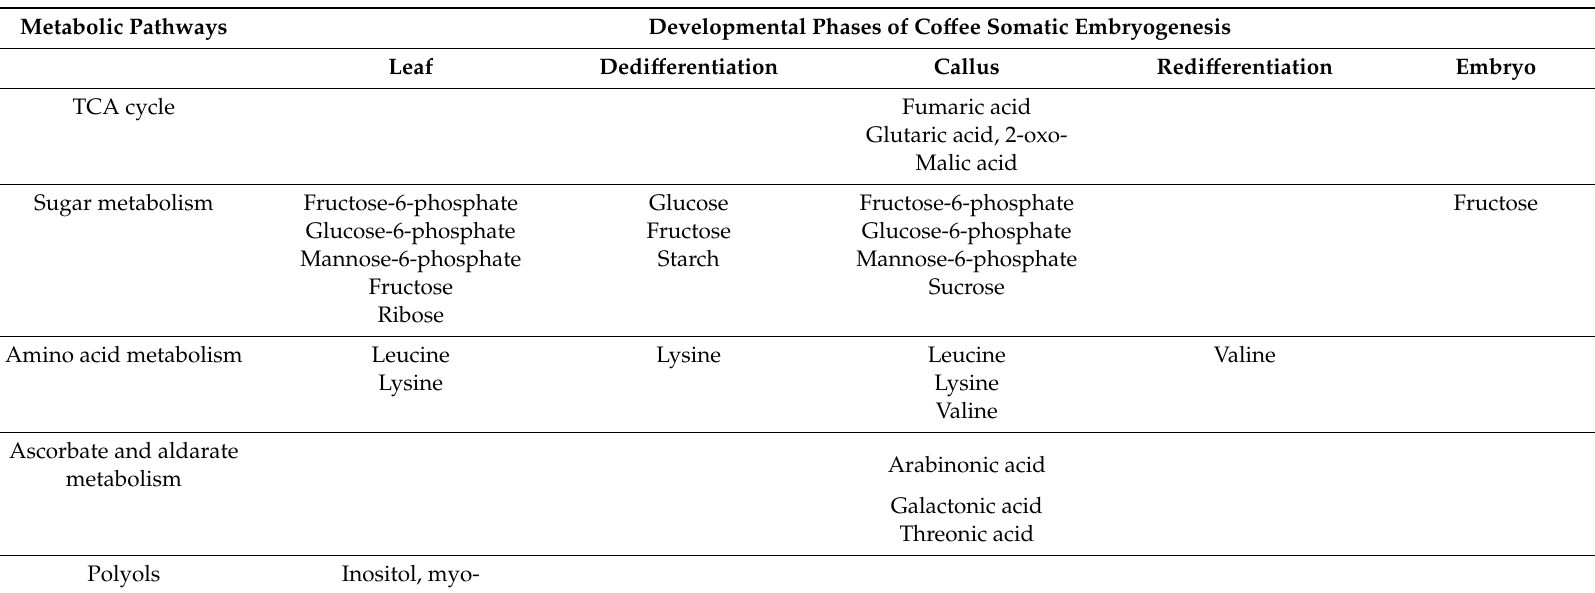
Table 3. Significantly under-accumulated metabolites in the five developmental phases forming the Arabica SE